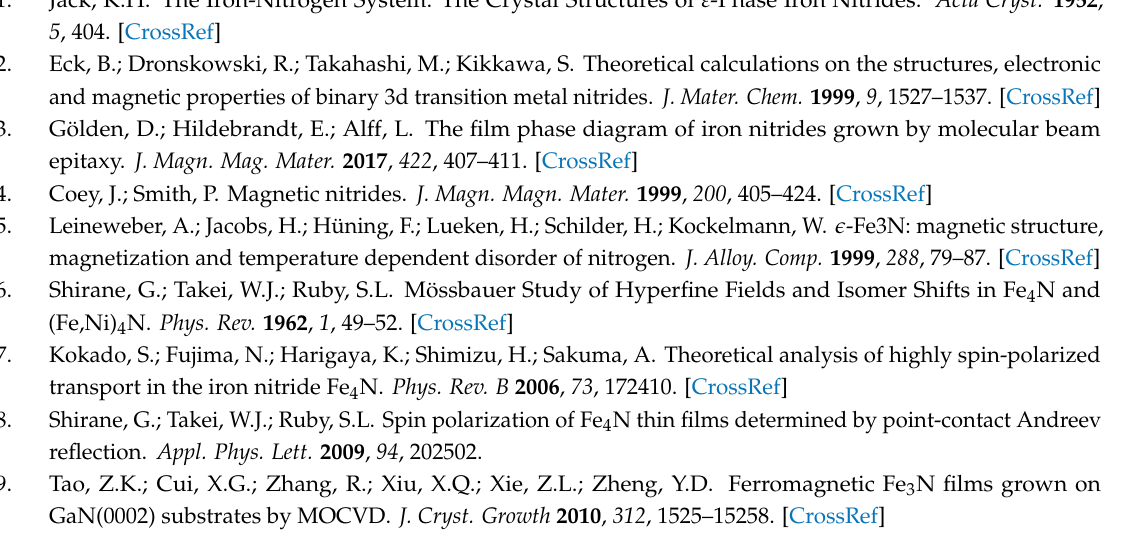
Figure S1: EDX line-scans vs. depth, and Figure S2: Angular dependence of the FMR